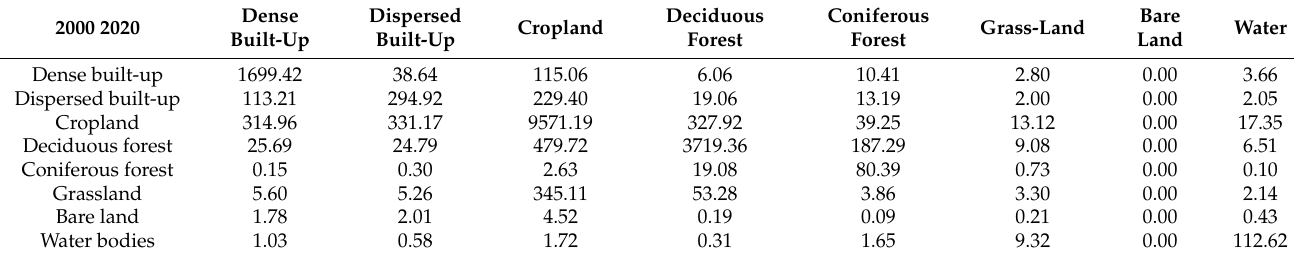
Table A2. Land cover area transfer matrix for the Paris Region from 2000 to 2020 (km 2 ).